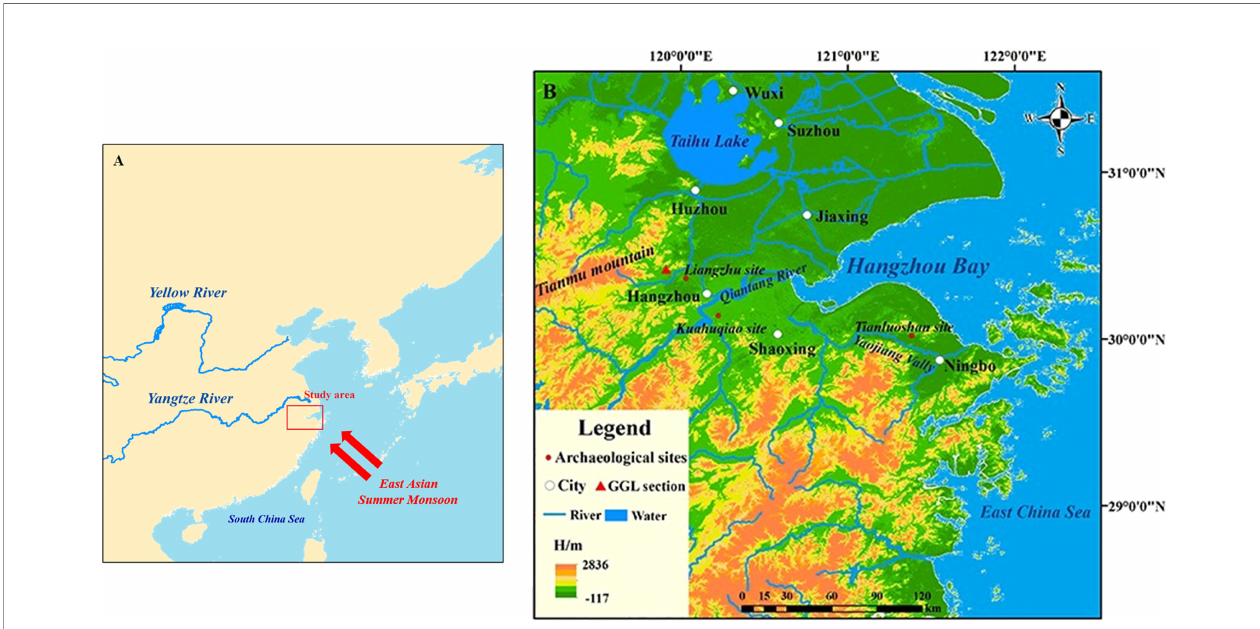
FIGURE 1 | (A) Location of the study area in the lower reaches of Yangtze River; (B) Speci fi c location of the GGL pro fi le and its surrounding